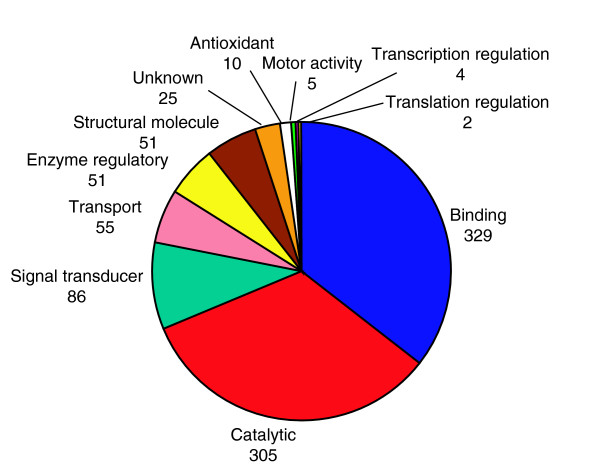
GoMiner analysis of the molecular function of identified proteins.